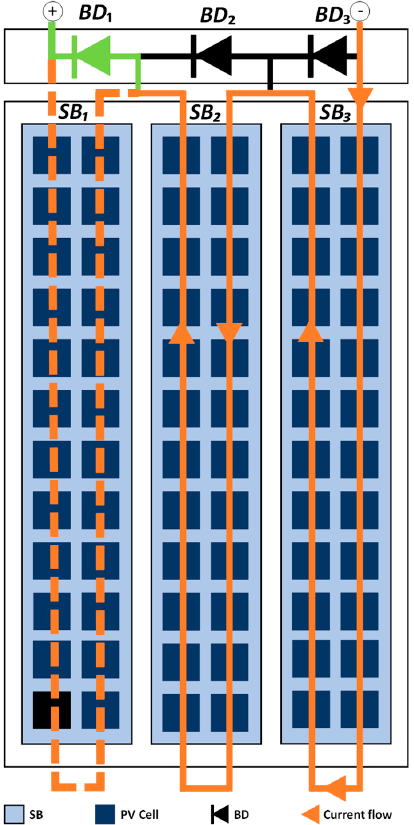
Figure 1. PV module configuration under in study showing 72 PV cells connected in three sub- modules, namely: SB ₁ , SB ₂ , and SB ₃ , and three bypass diodes, namely BD ₁ , BD ₂ , and BD ₃ . If only one PV cell (lower left corner) is fully shaded and stops generating electricity, no current will flow through that PV cell, resulting in zero power output for submodule block SB ₁ . Electricity then flows through bypass diode BD ₁ , disconnecting the entire submodule block SB ₁ , including the shaded PV cell, from the electricity flow.